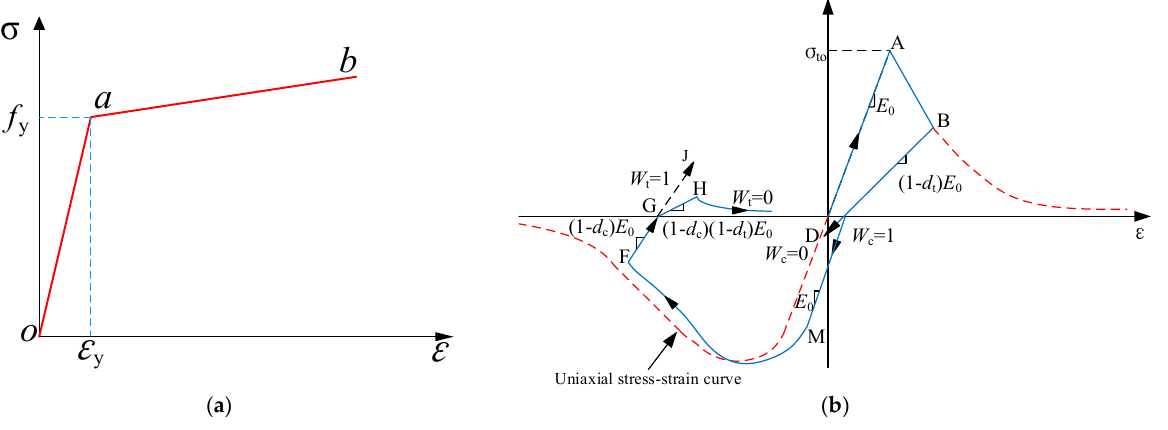
Figure 11. Material models of concrete and reinforcements. ( a ) Reinforcements. ( b ) Concrete.